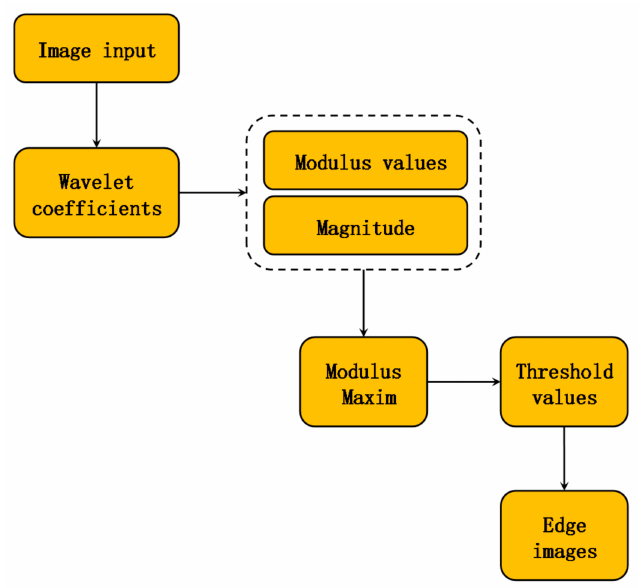
Figure 3. Wavelet transform modulus maxima